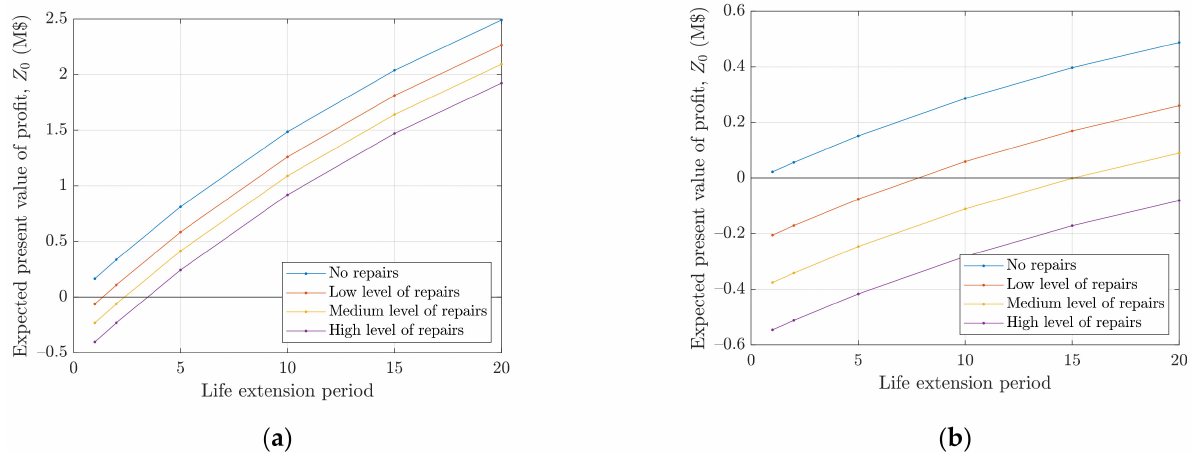
Figure 3. Expected present value of the profit Z 0 as a function of life extension period (when the risk of failure is not included) for various levels of retrofits for: ( a ) power purchase agreement (PPA) = 50; ( b ) PPA =